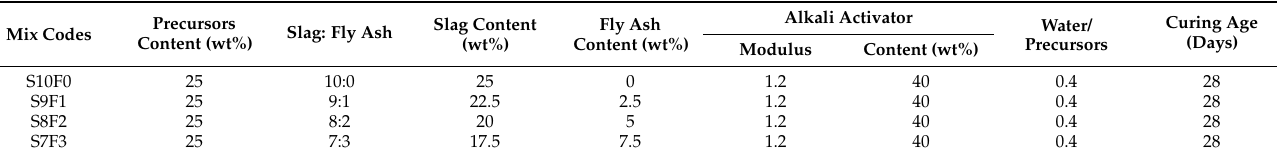
Table 3. Mixture design of the testing